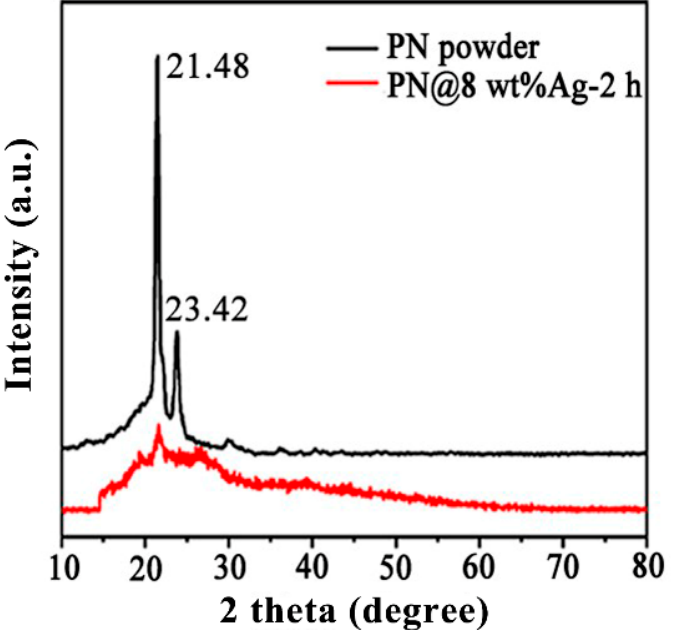
Figure 1. XRD patterns of PN powders, and the prepared PN@8 wt%Ag-2 h nanofiber membrane.